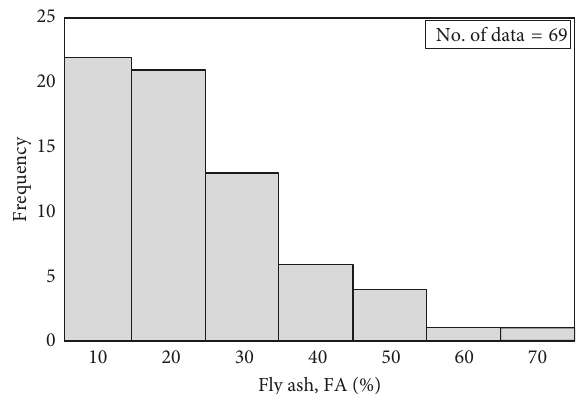
Figure 2: Histogram of percent of fly ash (FA) added to the cement